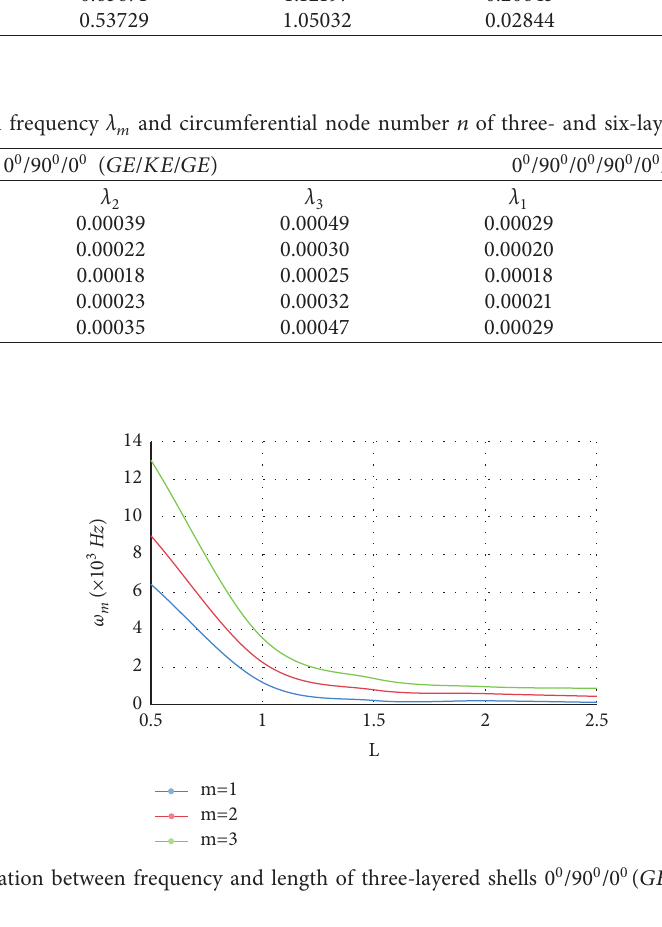
L of two-layered 0 0 /90 0 cylindrical shell n � 2. m and length